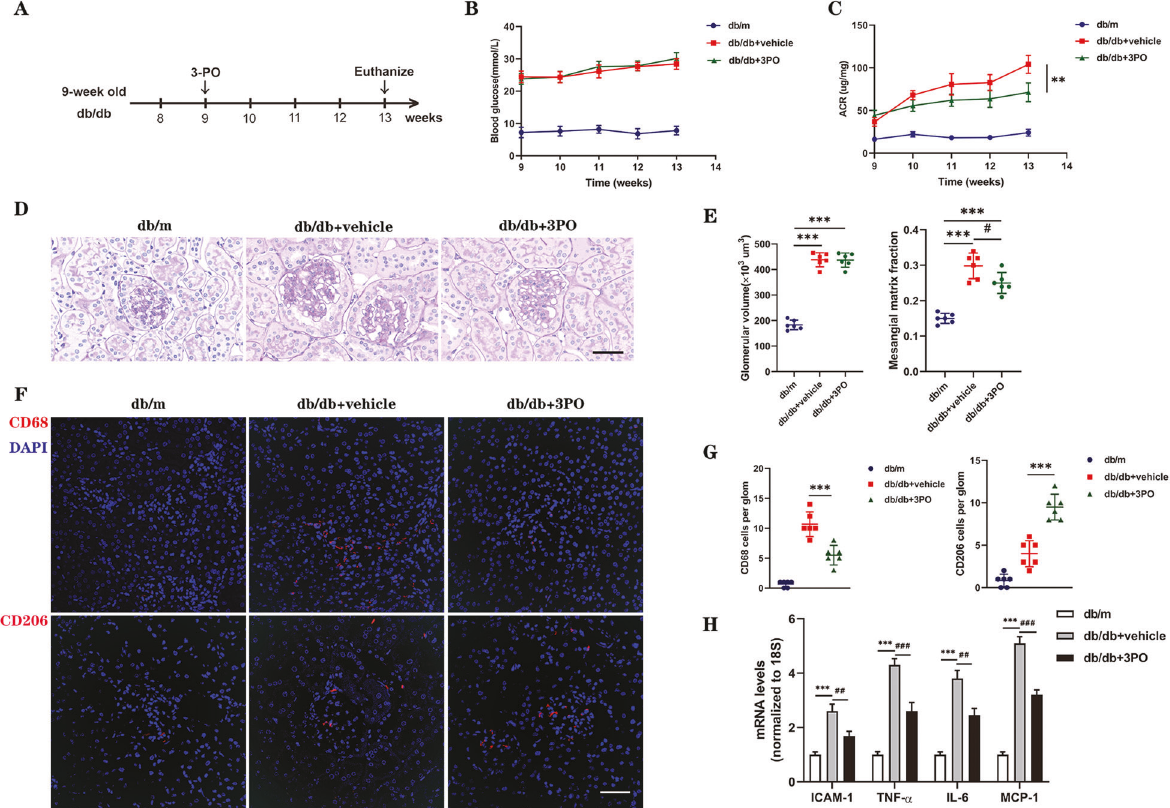
Fig. 7 3PO suppresses the progression of glomerulopathy in db/db mice. A Schematics showing the experimental design. 3PO or DMSO was intraperitoneally injected into 9-week-old db/db and db/m mice. The mice were euthanized at 4 weeks postinjection for analysis ( n = 6 mice per group). B , C Weekly blood glucose and ACR measurements of db/db and db/m mice. D Representative images of PAS-stained kidneys of db/db and db/m mice. Scale bar, 50 μ m. E Quanti fi cation of the glomerular volume and mesangial matrix fraction per mouse; n = 6 mice. F Representative images of CD68 and CD206 immuno fl uorescence. Scale bar, 50 μ m. G Quanti fi cation of CD68- and CD206-positive cells in db/ db and db/m mice. H RT – PCR analysis of the mRNA levels of ICAM-1, TNF- α , IL-6, and MCP-1 in db/m and db/db mice. n = 6 mice. The data are shown as the mean ± SD. ** P < 0.01, *** P < 0.001; # P < 0.05, ## P < 0.01, ### P <